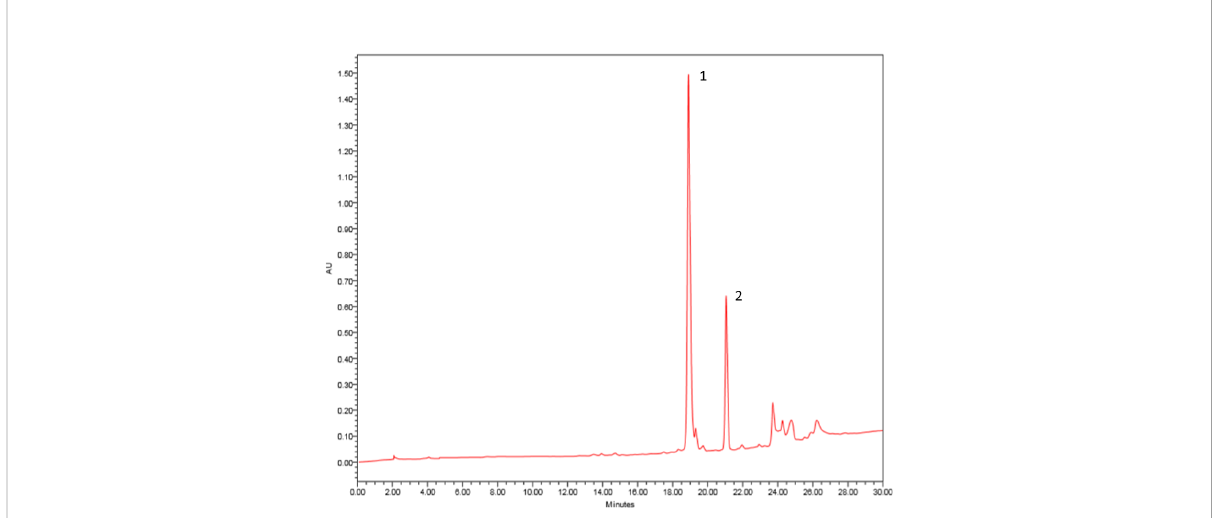
FIGURE 1 Chromatogram of F2 fraction of ethyl acetate extract obtained from Aspergillus sp. biomass. HPLC-DAD in preparative mode using a chromatograph Waters 1525 Binary HPLC Pump equipped with Waters 2998 DAD and Sun fi re ™ prep C18 OBD column (5 µm, 19 mm × 150 mm), 500 m l of injected volume, gradient elution H 2 O/MeOH (50 – 100%) for 30 min, fl ow of 13.0 ml/min. The wavelength scanning was in the range of 210 – 600 nm. Pseurotin A (1) and monomethylsulochrin